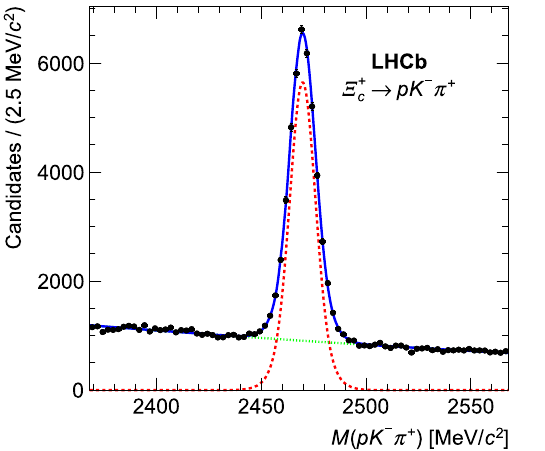
sum of two Gaussian functions with the same mean and different widths (red dashed line) and a second-order Chebyshev polynomial function (green dotted line) describing the signal and background